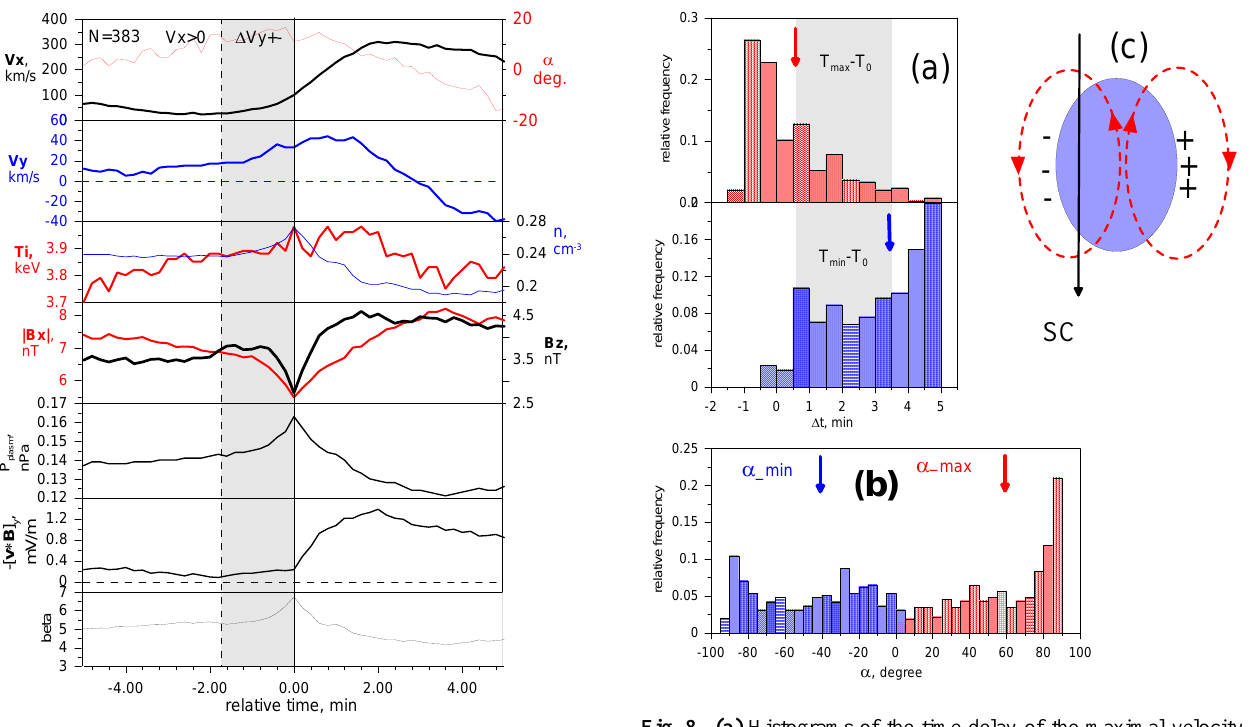
Figure 7 Average velocity, magnetic field and plasma parameter Fig. 7. Average velocity, magnetic field and plasma parameter vari- variations for one group of the earthward moving fast flows. Reference time is defined as the time of the plasma pressure ations for one group of the earthward moving fast flows. Reference maximum time is defined as the time of the plasma pressure maximum.